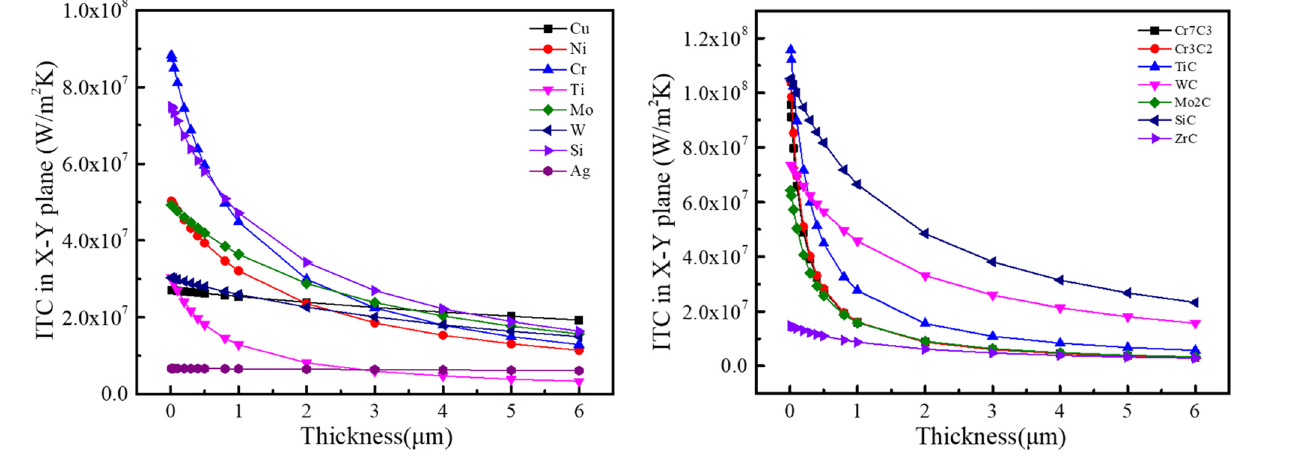
Figure 4: ITC of graphite fl akes/Al composites with typical carbide coatings as a function of coating